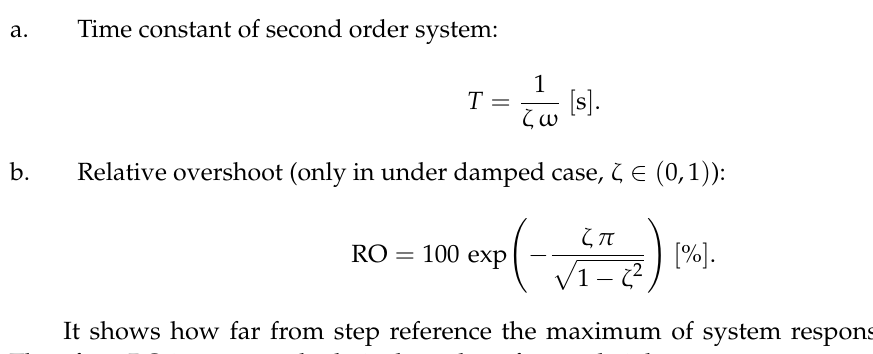
Figure B1. Main performance parameters of second order step response. Figure A2. Main performance parameters of second order step